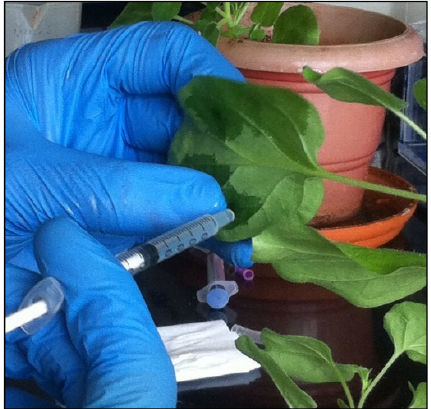
Figure 5. Syringe infiltration; plant leaves were infiltrated using syringe without needle on the abaxial leaf surfaces.